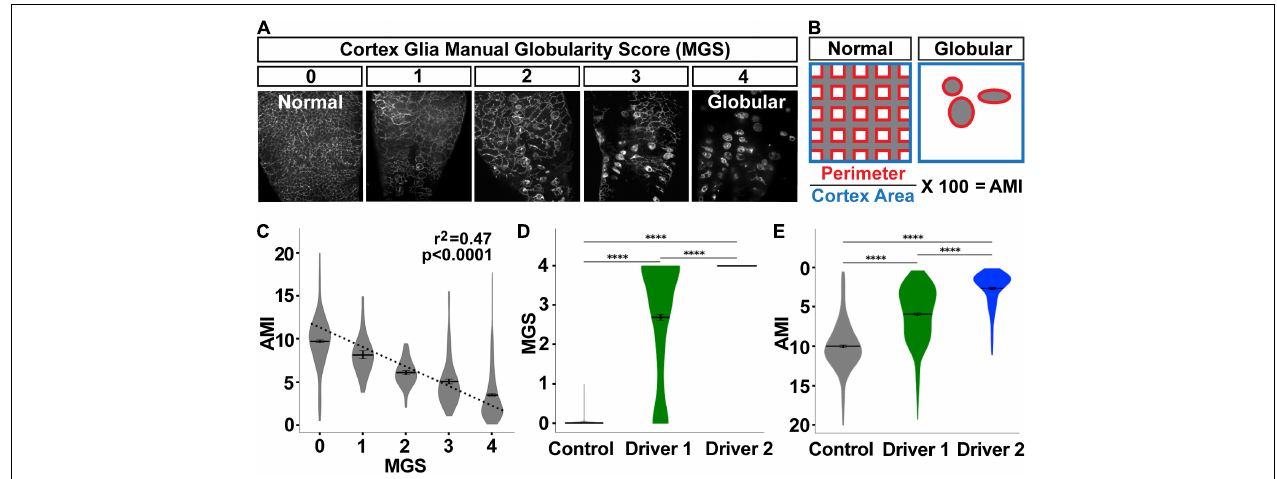
FIGURE 4 | Automated morphology index (AMI) significantly correlates with manual scores for cortex glial globularity. (A) Cortex glial morphology was manually quantified using a 0–4 range, with 0 being normal mesh-like morphology, and 4 being almost completely globular (manual globularity score, MGS). (B) The automated morphology index (AMI) was calculated in the pipeline by measuring the perimeter of the cortex glia divided by the total area of the cortex. (C–E) AMI and MGS shows a significant negative correlation ( C , p < 0.0001, r 2 = 0.47, dotted line denotes the regression line). As globularity increases after RNAi knockdown using driver 1 (weaker) or driver 2 (stronger) (D) , the AMI decreases ( E , inverted y -axis for ease of comparison to MGS). **** p < 0.0001.